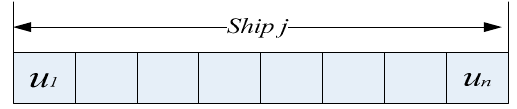
Figure 4. The encoding scheme of frog position.